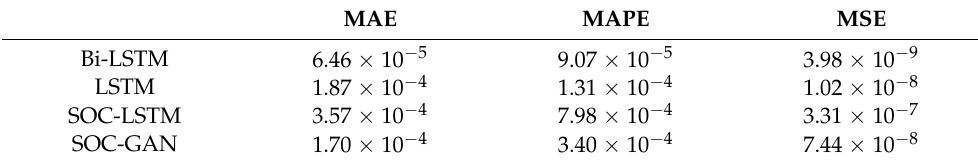
Table 7. Statistical indicator distributions for multiple ship trajectory